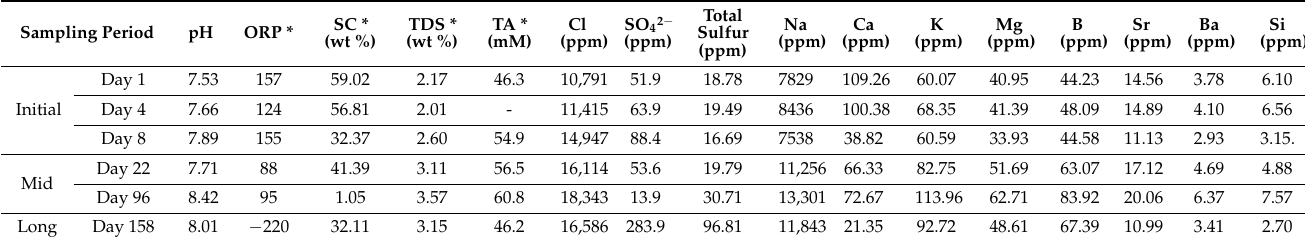
Table 1. Physicochemical characteristics of the mud